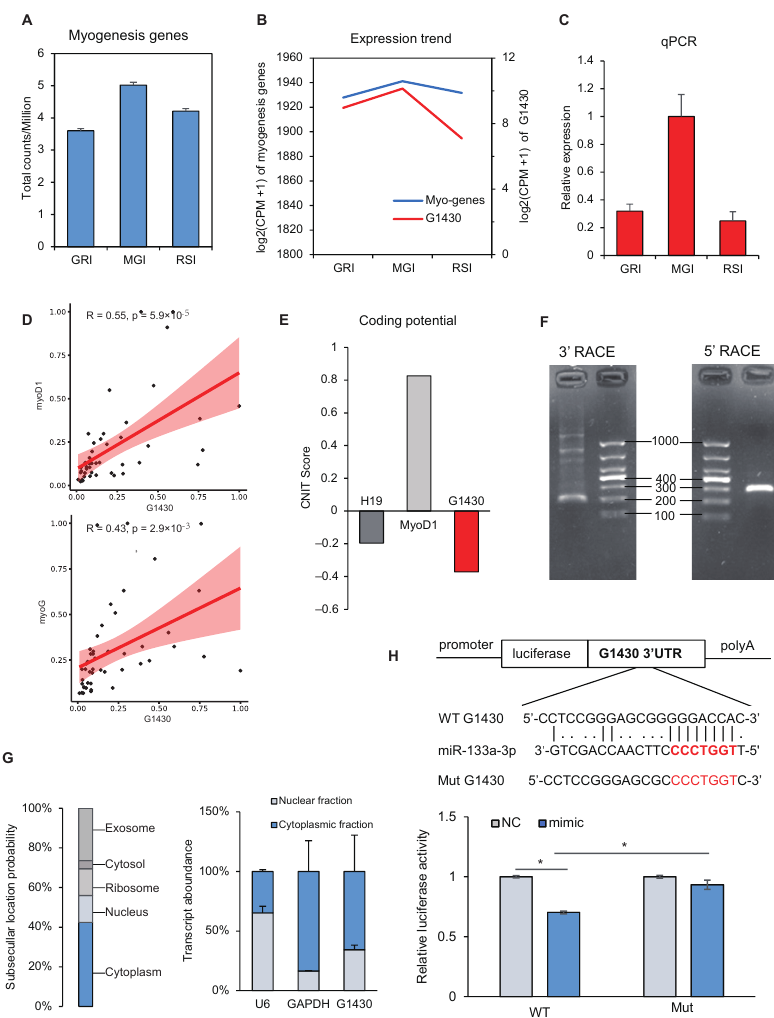
Figure 5. The expression and function of lncRNA G1430 in muscle development. ( A ) lncRNA G1430 expression was up-regulated at the MGI stage compared with the other two stages. ( B ) lncRNA was found to have a similar expression pattern with these myogenesis related genes. ( C ) lncRNA G1430 expression was confirmed by qRT-PCR. The data are shown as the mean ± SD. ( D ) Scatter plot of lncRNA G1430 and myoD1 (up), myoG (bottom). The Pearson correlation and p value were showed in the diagram. ( E ) The coding potential predication of lncRNA G1430 . Analysis was obtained from the CNIT (http://cnit.noncode.org/CNIT/). The porcine H19 represents a non-coding transcript (positive control) and the porcine myoD1 represents a coding transcript (negative control). ( F ) Results of lncRNA G1430 3 (cid:48) RACE (left) and 5 (cid:48) RACE (right). 3 (cid:48) RACE product, 220 bp. 5 (cid:48) RACE product, 300 bp. DNA Marker: DL1000. ( G ) Prediction of subcellular localization by lncLocator (http://www.csbio.sjtu.edu.cn/bioinf/lncLocator/) (left) and the nucleocytoplasmic fractionation of porcine cells by qRT-PCR (right). U6 RNA served as a nuclear location control and GAPDH was used as a cytoplasmic location control. ( H ) The sequence and binding sites between lncRNA G1430 and ssc_miR-133a-3p (up). The relative luciferase activity is normalized to the value of control miRNA and empty vector (bottom). Data are shown as means ± SD. * p < 0.05, Data are representative of at least three independent experiments. Abbreviations: MGI, the inflection point with the maximum growth rate; GRI, the inflection of the gradually increasing stage to the rapidly increasing stage; RSI, the inflection point of the rapidly increasing stage to the slowly increasing